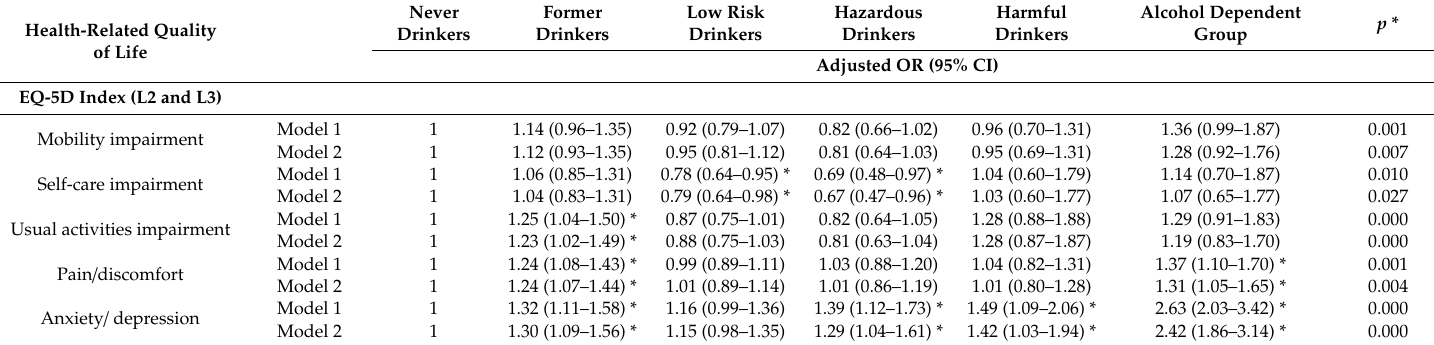
Table 2. Adjusted odds for impaired health-related quality of life associated with alcohol drinking patterns.